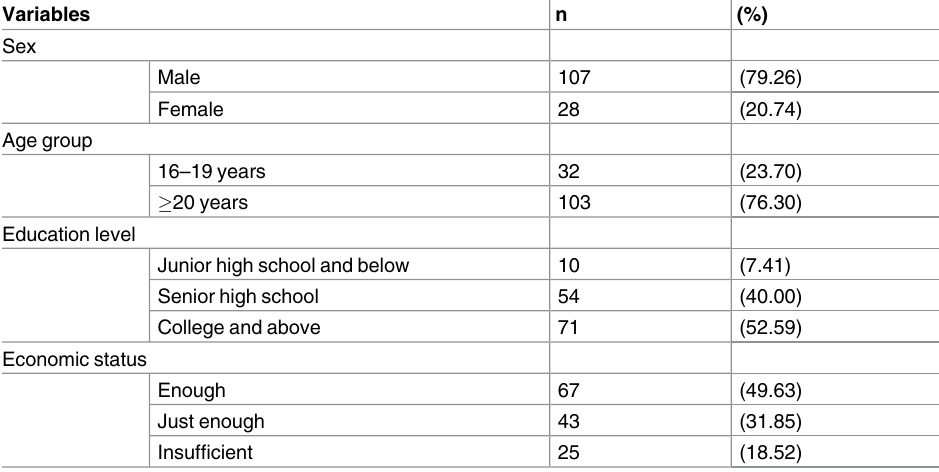
Table 1. Demographic characteristics at pretreatment for 135 subjects. Variables